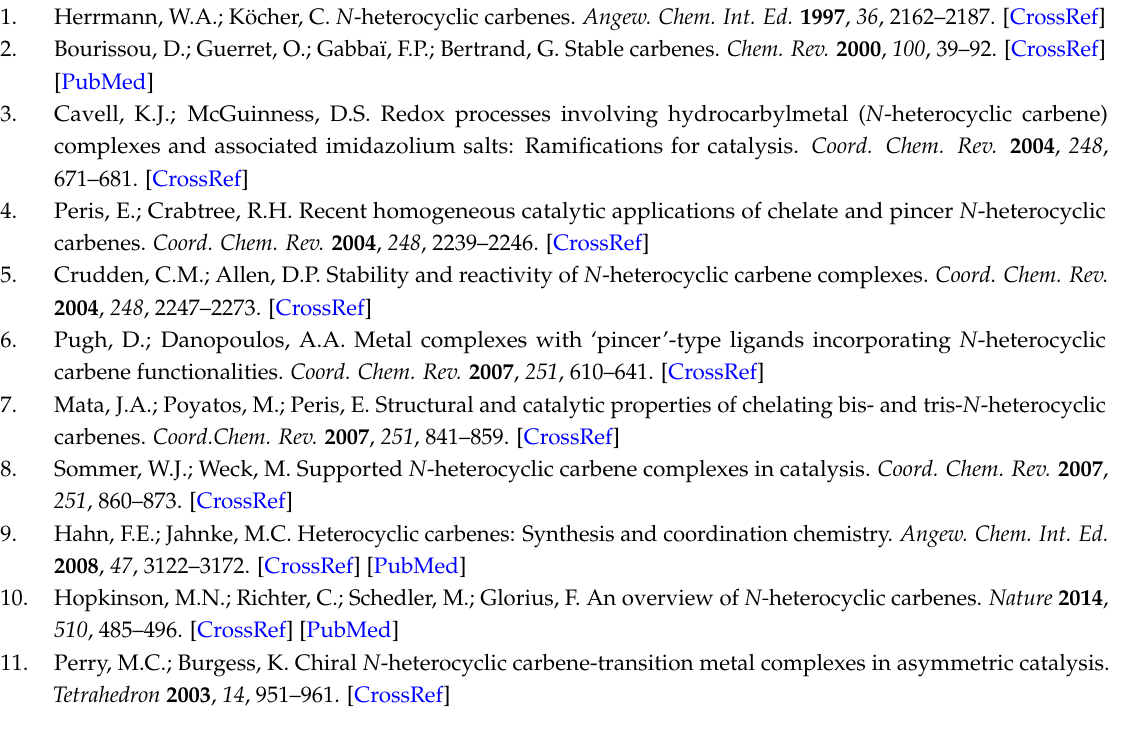
Figure S1: 1 H and 13 C NMR Spectra of compounds 2a – g , Figure S2: HR-MS Spectra for Compounds 2a – g , Figure S3: HPLC data of 4a – l